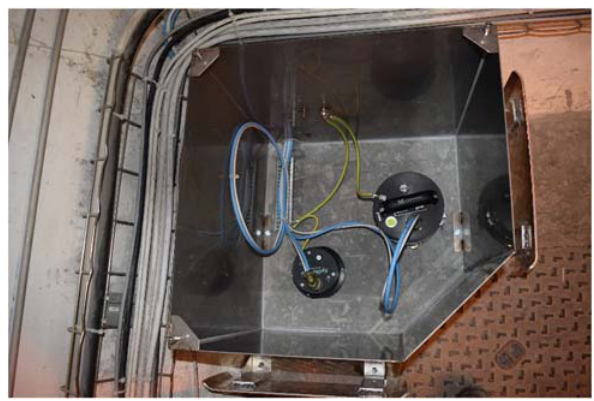
Figure 2: Vibrometers placed inside the Point 5 seismic station: strong motion sensor ( left ) and broadband sensor ( right ) .